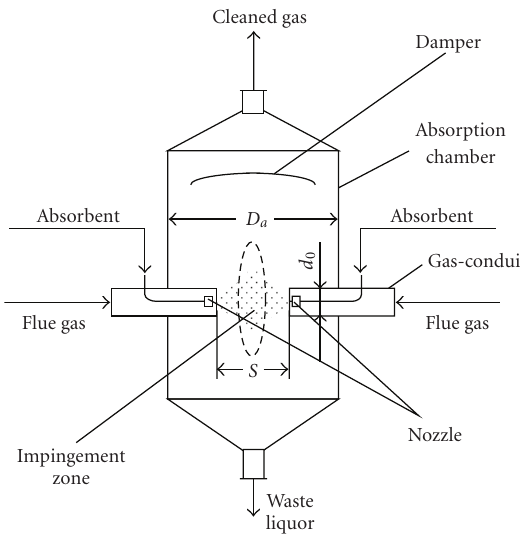
Figure 3: A brief view of GIS gas-liquid reactor.